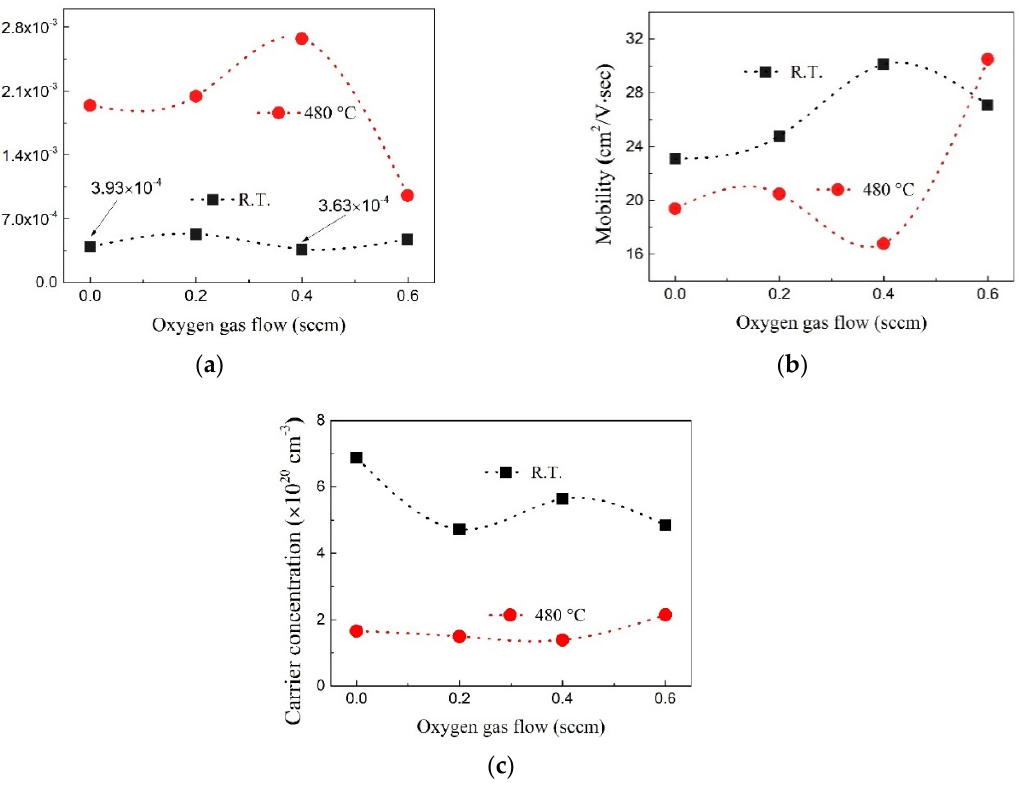
Figure 2. Electrical properties of ITO films. The following are functions of oxygen-gas flow without post-annealing and with post-annealing at 480 °C: ( a ) resistivity, ( b ) mobility, and ( c ) carrier con- centration.